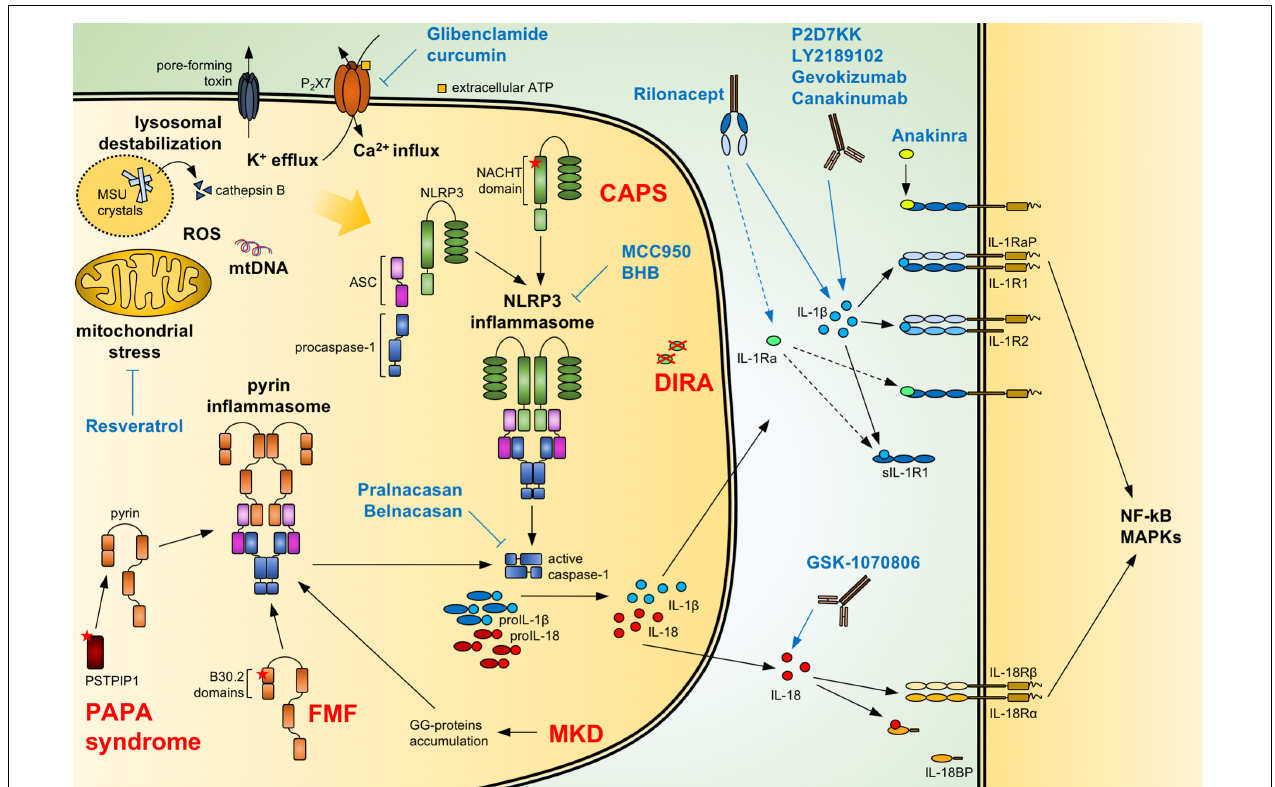
FIGURE 1 | Regulation of IL-1/18 production and current IL-1/18 antagonists. Pathogen- and danger-associated molecular patterns can induce the formation of a functional inflammasome via events including mitochondrial stress with release of oxidized mtDNA, ROS, lysosomal destabilization with cathepsin B release, changes in intracellular calcium (Ca 2 + ) and potassium (K + ) efflux. Also, mutations of NACHT-PYD domains of NLRP3 in cryopyrin-associated periodic syndromes ( CAPS ) lead to the activation of the NLRP3 inflammasome. Similarly, mutations of B30.2 domains in familial Mediterranean fever ( FMF ) and of PSTPIP1 in PAPA syndrome or accumulation of geranylgeranylated proteins (GG-proteins) in mevalonate kinase deficiency ( MKD ) lead to activation of the pyrin inflammasome. Activated inflammasomes recruit procaspase-1 via the adaptor ASC. Autocatalytically cleaved and activated caspase-1 can then process IL-1 β and IL-18. The secreted cytokines bind to the IL-1 receptor (IL-1R1:IL-1RaP) and IL-18 receptor (IL-18R α :IL-18R β ), respectively, resulting in NF- κ B and MAPKs signaling. Soluble IL-1R1 (sIL-1R1), IL-1R2 and IL-18 binding protein (IL-18BP) can block the signaling pathway. Caspase-1 activity can be modulated by the specific inhibitors Pralnacasan and Belnacasan . The activation of the NLRP3 inflammasome can be inhibited with Glibenclamide and curcumin inhibiting or downregulating the ATP-sensitive K + -channels P 2 X7, respectively; with Resveratrol increasing autophagy and inhibiting mitochondrial stress; and with the specific NLRP3 inhibitors MCC950 and BHB . Anakinra and the secreted IL-1 receptor antagonist (IL-1Ra), absent in deficiency of IL-1 receptor antagonist ( DIRA ) patients, compete with IL-1 β and IL-1 α (not shown) for binding to the IL-1 receptor. Rilonacept acts as a soluble decoy binding IL-1 β and with lower affinity IL-1 α (not shown) and IL-1Ra. The recombinant antibodies Canakinumab , Gevokizumab , LY2189102, and P2D7KK specifically target and neutralize IL-1 β . Similarly, GSK-1070806 and MABp1 inhibits IL-18 and IL-1 α (not shown), respectively. Blue arrows: inhibitory effect; dotted arrow: low affinity; ASC, apoptosis associated speck-like domain protein containing a CARD; MSU, monosodium urate; mtDNA, mitochondrial DNA; ROS, reactive oxygen